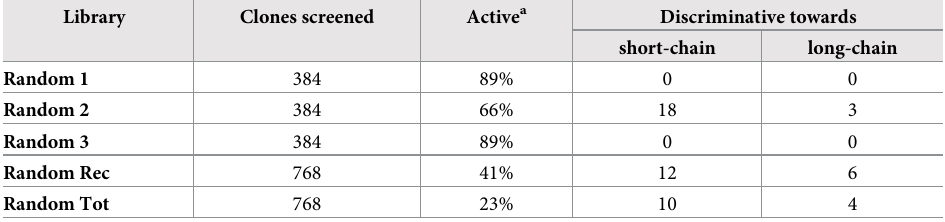
a Variants were screened for halo formation around colonies spotted via automation on solid medium. Variants were considered active only when halo formation was